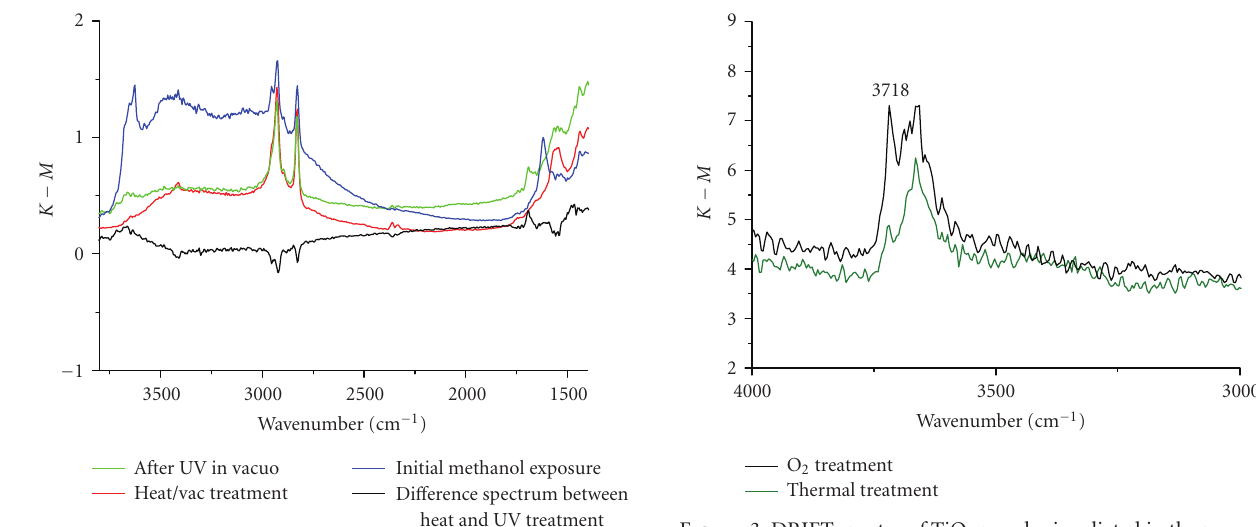
Figure 3: DRIFT spectra of TiO 2 powder irradiated in the presence of methanol vapor, followed by either thermal or O 2